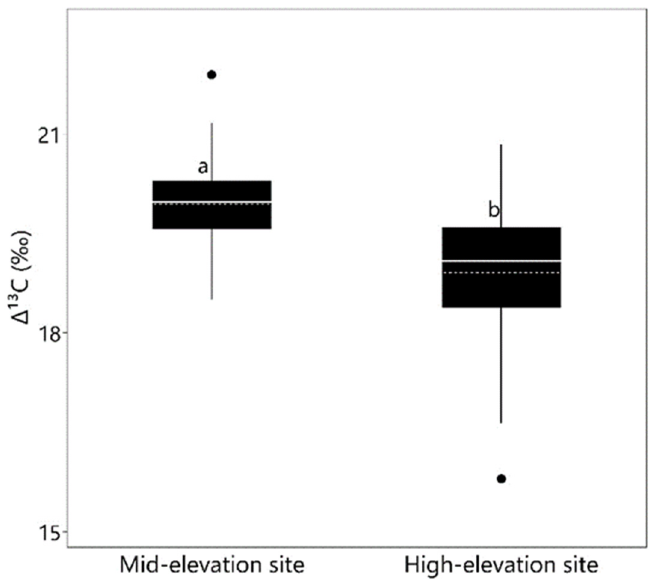
Figure 6. Leaf carbon isotope discrimination ( ∆ 13 C) averaged over all provenances by planting site. Dashed lines are mean, and solid lines are the median. Means followed by the same letter do not differ significantly (Tukey’s HSD tests; α = 0.05).